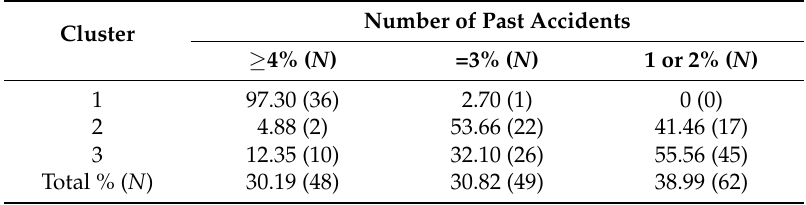
Table 3. Distribution of individuals according to accident number as a function of